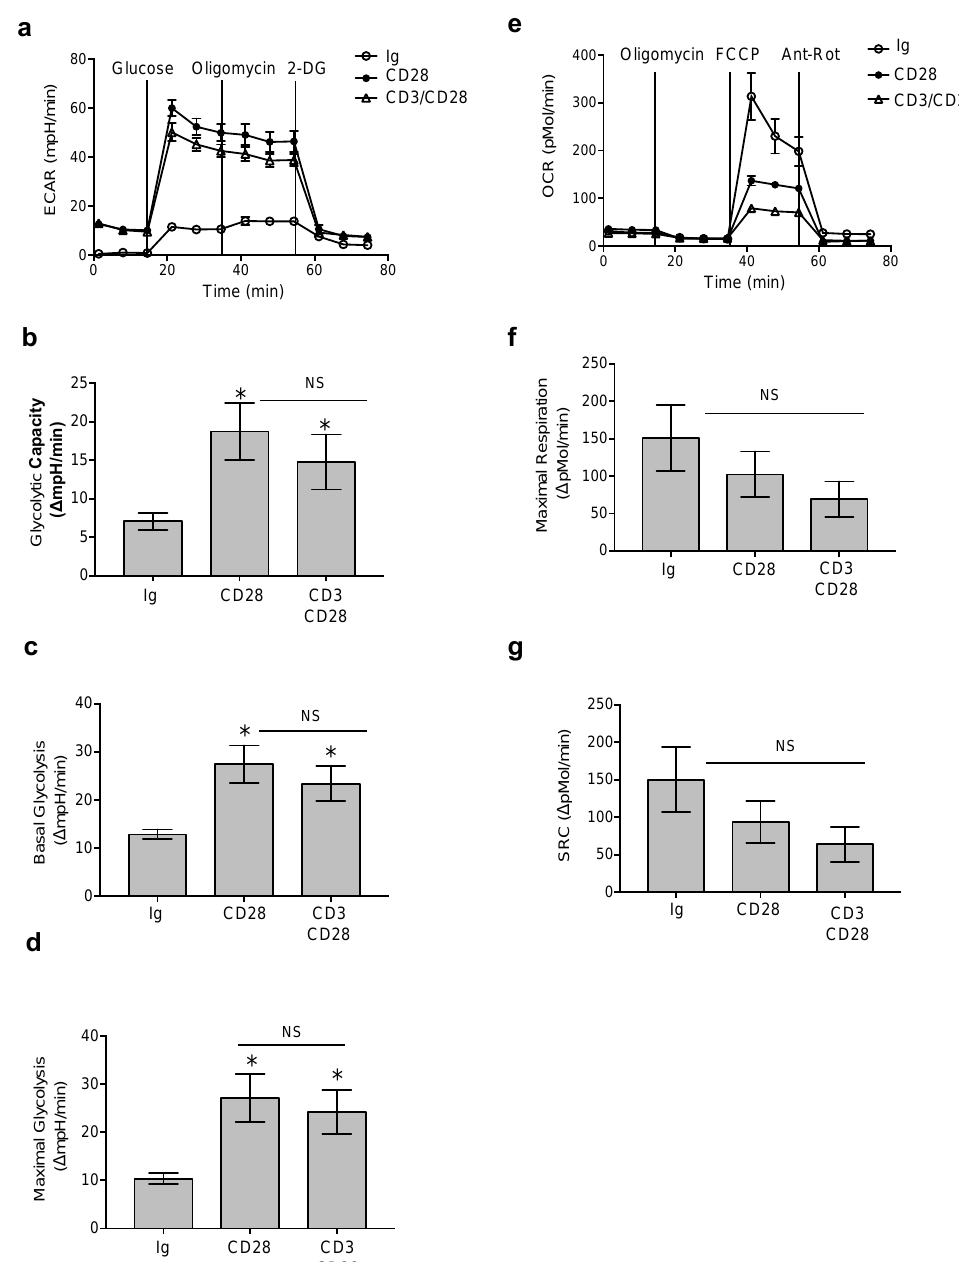
Figure 1. CD28 activates glycolysis in CD4 + T cells. ( a ) Peripheral blood CD4 + T cells from a representative healthy donor (HD) were stimulated for 18 h with 2 µ g mL − 1 isotype control Ig, or anti-CD28.2 or anti-CD28.2 plus anti-CD3 (UCHT1) Abs. The kinetic profile of the extracellular acidification rate (ECAR), was measured by Seahorse analysis, at a basal level and after addition of glucose, oligomycin and 2-DG. Data express the mean ± SEM of sextuplicate cultures. ( b–d ) CD4 + T cells from HDs ( n = 7) were activated as in ( a ) and glycolytic capacity ( b ), basal glycolysis after glucose injection ( c ) and maximal glycolysis ( d ) were calculated from the ECAR profiles. Data express mean ± SEM. ( e ) CD4 + T cells from a representative HD were activated as in ( a ) and the oxygen consumption rate (OCR) was measured by Seahorse analysis at a basal level and after addition of oligomycin, FCCP, antimycin A and rotenone (Ant-Rot). Data express the mean ± SEM of sextuplicate cultures. ( f , g ) Maximal respiration ( f ) and spare respiratory capacity (SRC) of CD4 + T cells from HDs ( n = 5) activated as in ( a ) were calculated from the OCR profiles. Data express mean ± SEM and significance was calculated by Wilcoxon test. (*) p < 0.05, NS = not